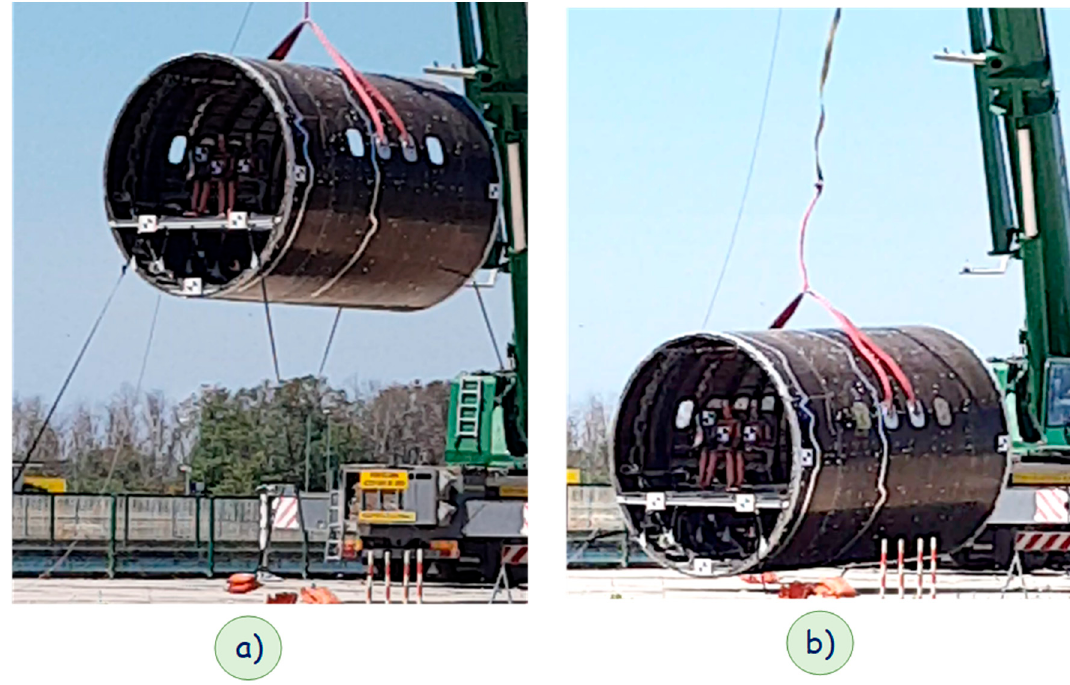
Figure 6. Fuselage section drop test: ( a ) Before the drop test; ( b ) during the